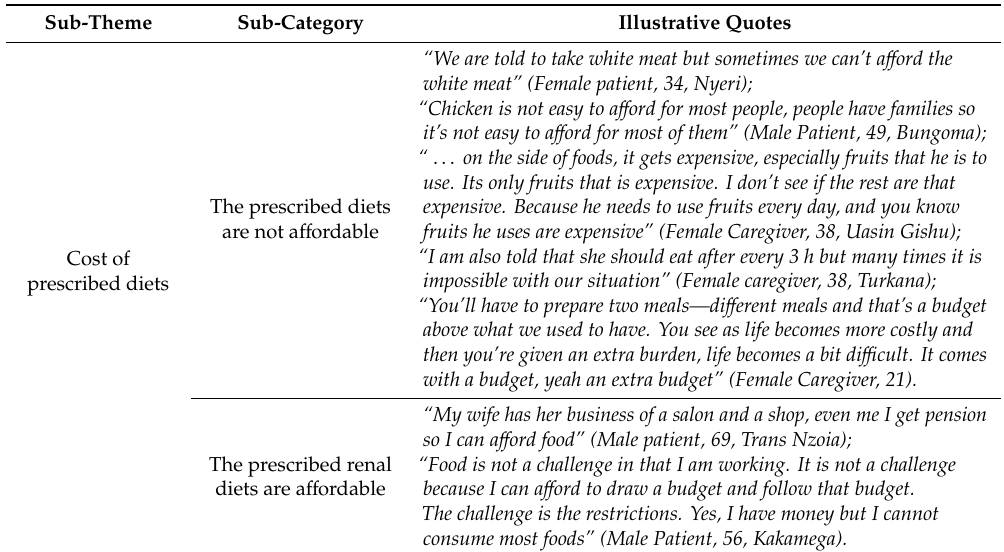
Table 3. Sub-theme 3—illustrative quotes on “cost of prescribed renal